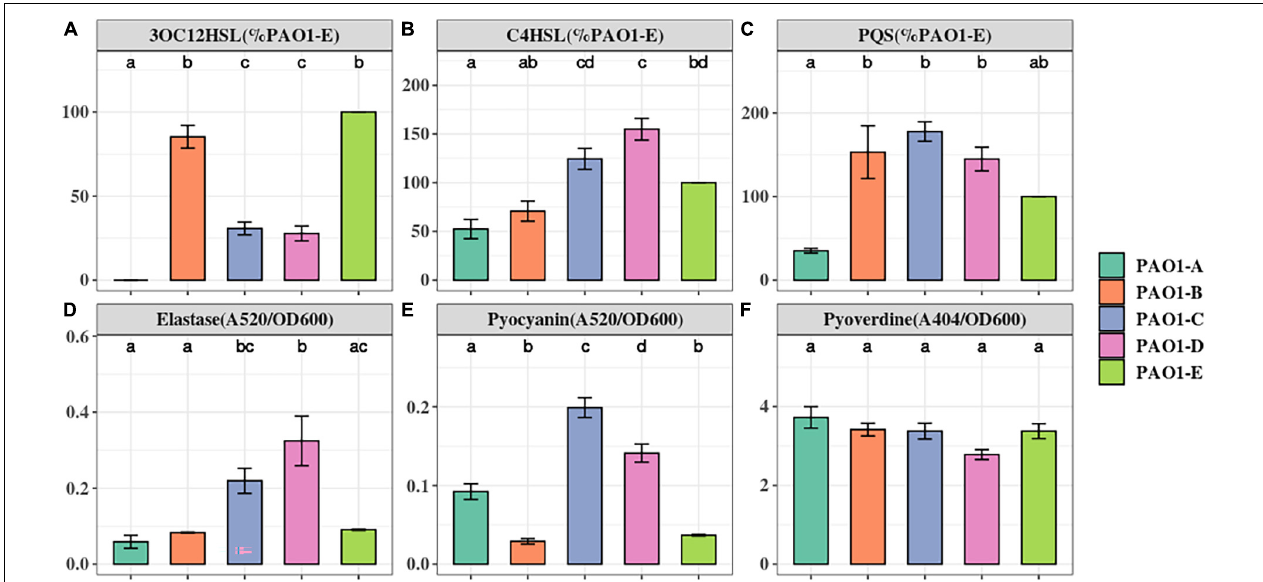
FIGURE 1 | The Quorum Sensing signals and virulence factors production in P. aeruginosa PAO1 sublines. The level of QS signals (A–C) produced were compared to that of the PAO1-E with the mean set to 100%. The level of virulence factors (D–F) were normalized by cell density (OD600). The small letter alphabets on the data points signify the statistically significant differences between the data points. Different alphabets on the data points signify significant differences between those points. More than one alphabet on one strain shows its significance across two or more groups. The individual sublines (x-axis) are denoted by the specified colors of the figure label. Data represent the mean+/ − SD of three independent